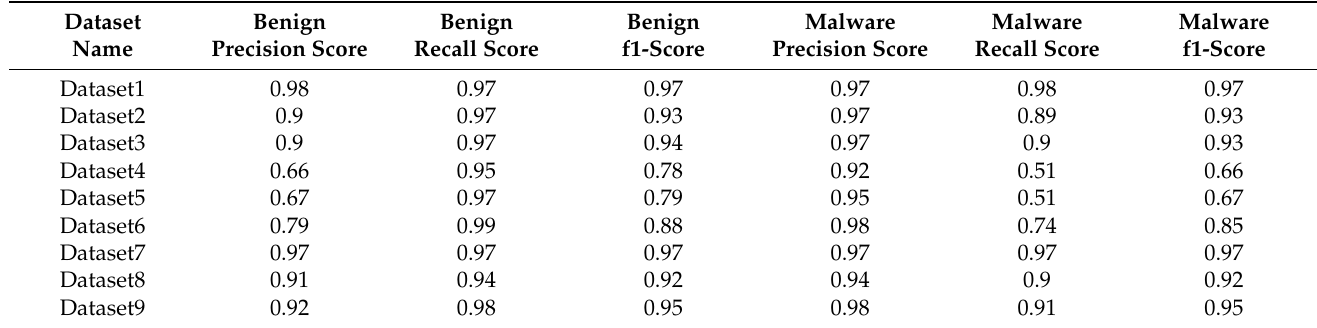
Table 10. Predication results when using the DL algorithm with minimum features.